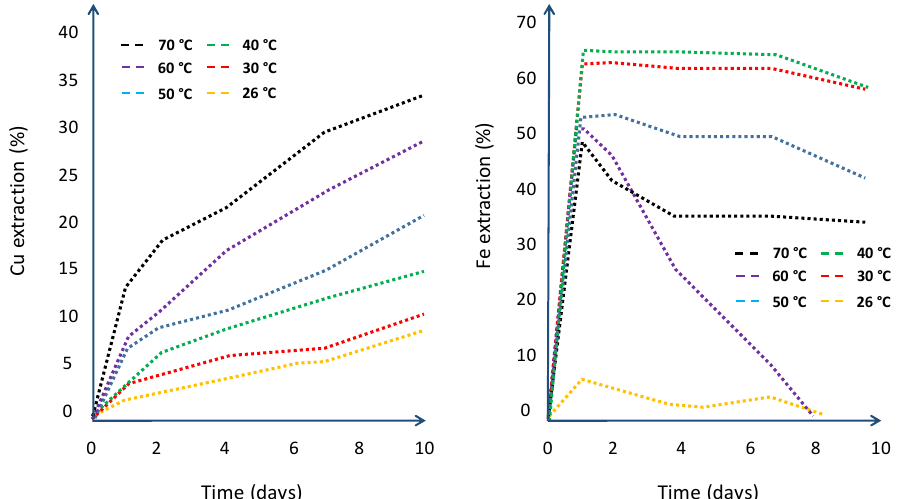
Figure 11. Extraction of copper and iron in 25 g/L Fe 3+ /Fe 2+ , 10 g/L Al 3+ , 1 g/L Mg 2+ , 0.2 g/L Cu 2+ , 125 g/L SO 42 − , pH of 1.2, E h of 700 mV, and pH 1.2 at varied temperature (Modified from [10]).